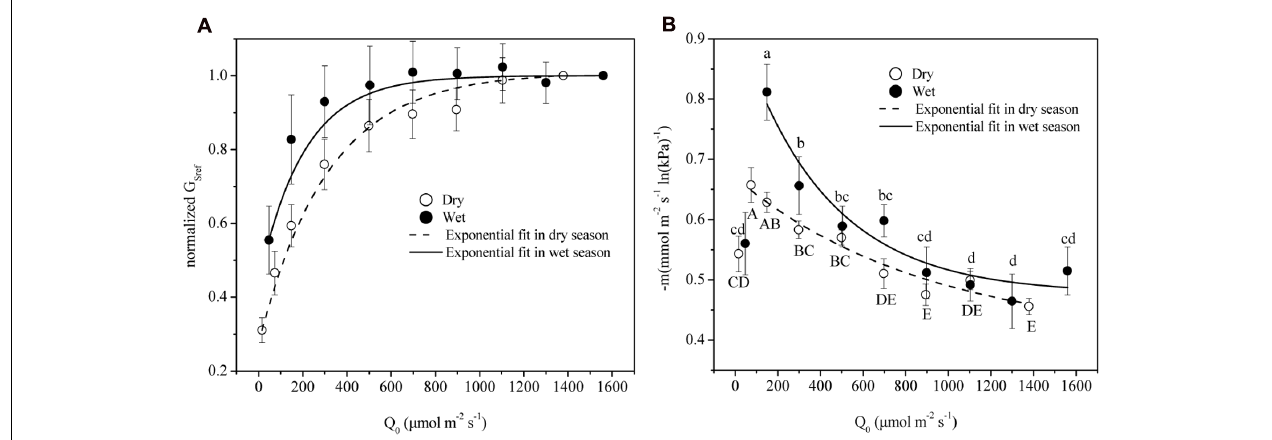
FIGURE 5 | (A) G Sref (G s of each tree at D = 1 kPa) normalized based on the highest value in relation to mean photosynthetically active radiation (Q 0 ). (B) The stomatal sensitivity (–m) of each tree in relation to Q 0 in dry (open symbols) and wet seasons (solid symbols). Symbols are the mean ± SD of all 15 trees for each light group. Lines are least-square fit through the entire data. Symbols with same letters shown in (a) indicate non-significant differences among light groups, where capital/lower cases refer to dry/wet season.